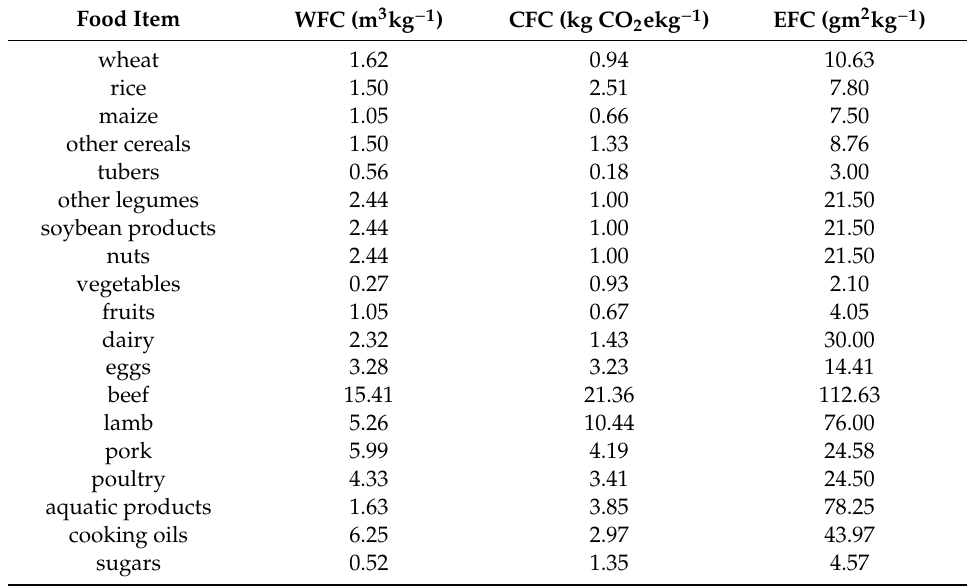
Table 2. Coe ffi cients of the water footprint (WFC), carbon footprint (CFC), and ecological footprint (EFC) of each food